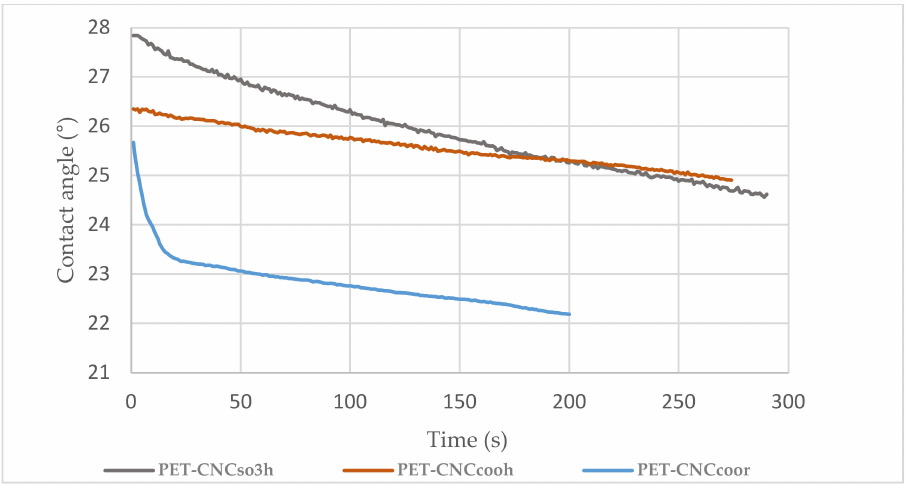
Figure 6. Water contact angle values versus time of PET film coated with the three types of cellulose